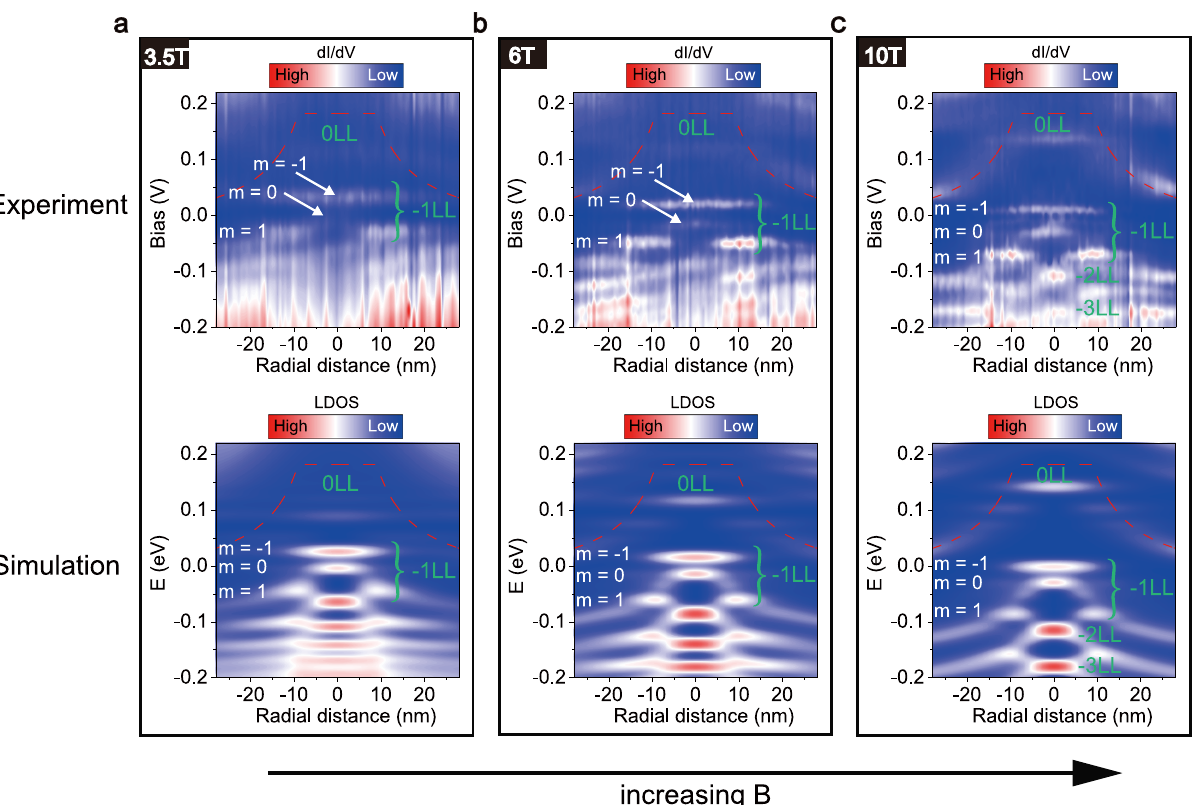
Fig. 3 Lifting the orbital degeneracy of Landau levels (LLs) in the GQD. Top panels of a – c , the radially d I /d V spectroscopic maps on the GQD ( β = 2.4, r = 9 nm) in the case of a series of magnetic fi elds. Bottom panels of a – c , the calculated space-energy maps of the LDOS of the GQD with different 0 magnetic fi elds. The m = − 1, m = 0, and m = 1 indicate the split orbital states of the − 1 LL. The red dotted lines indicate Dirac point energy.